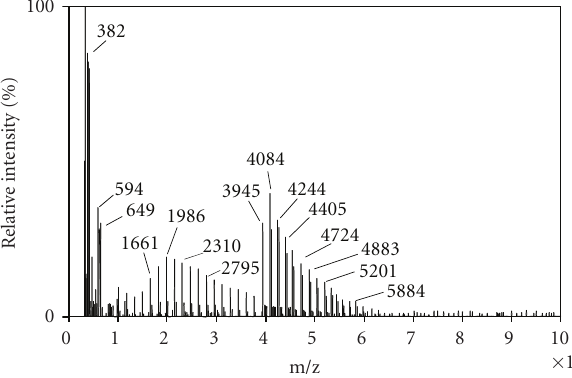
Figure 4: MALDI MS spectrum of a standard solution (1.0mgmL − 1 ) of Frutafit TEX. THAP was used as matrix. Other conditions as reported in Figure 2.